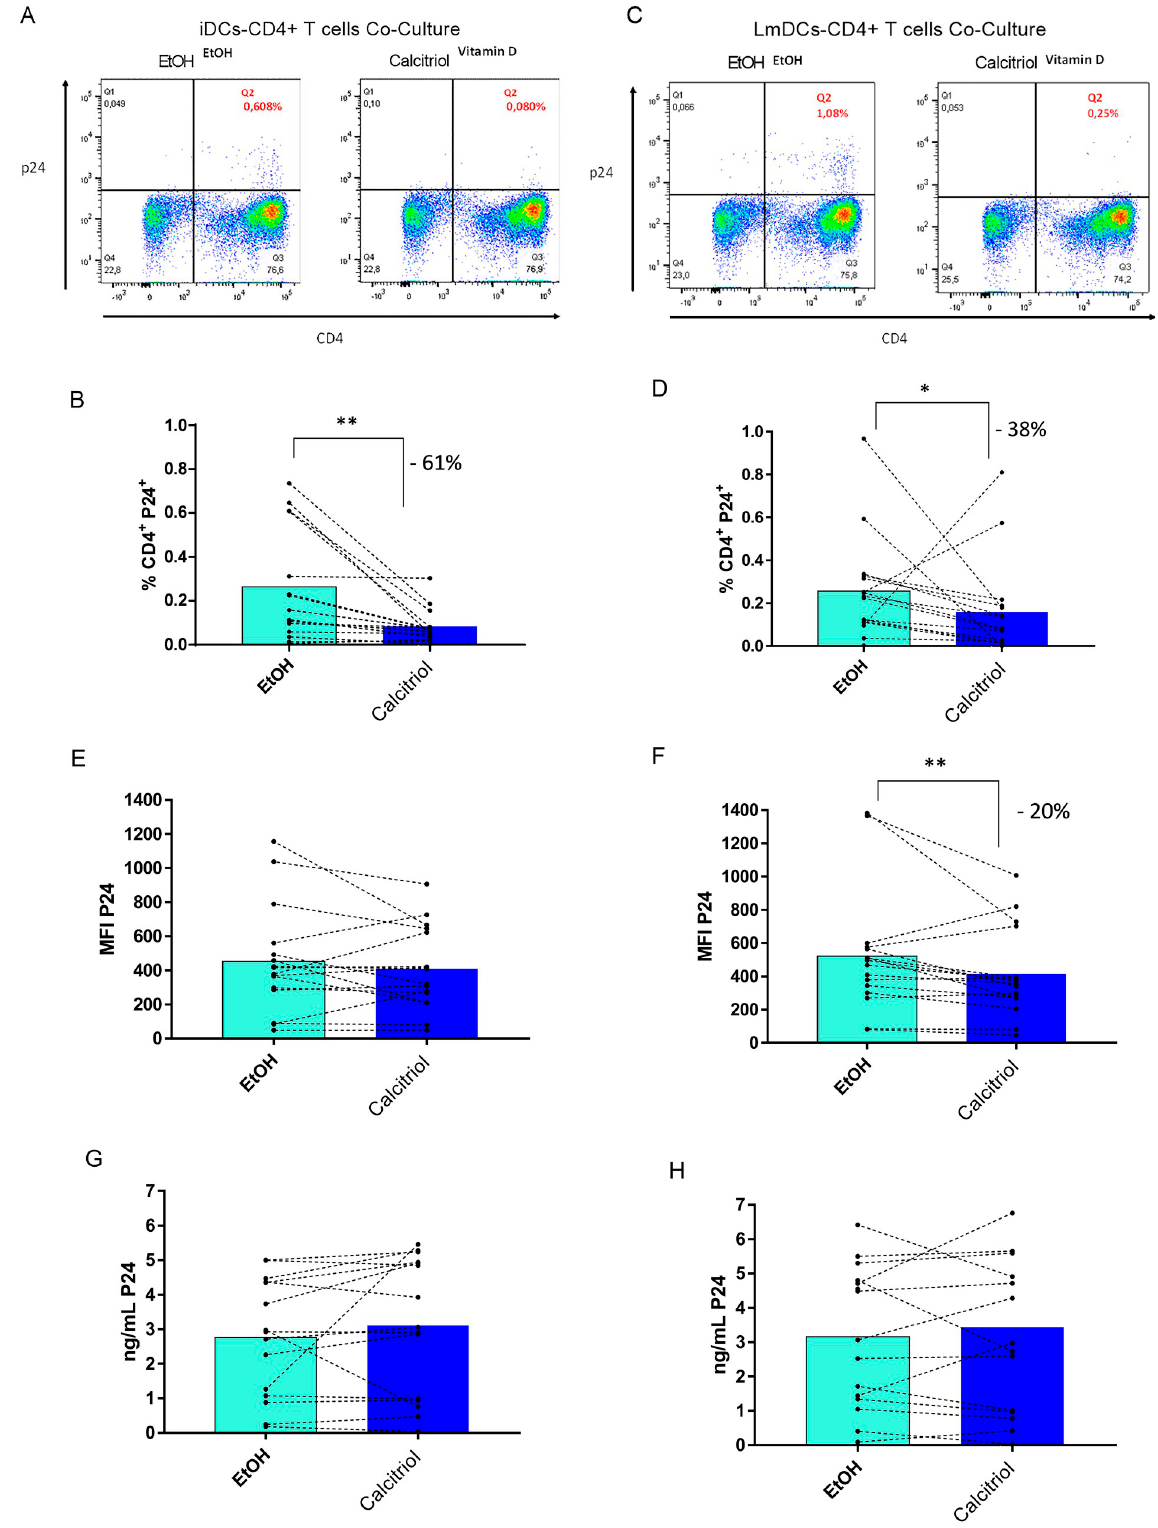
Fig 1. Percentage of infected CD4+ T cell is reduced when co-cultured with HIV-1 pulsed calcitriol-treated DCs. iDCs (left panel) and LmDCs (right panel) were pulsed with X4 tropic virions (H9-HTLV-IIIB) and co-cultured with CD4+ T cells. After 72 h, the viral protein p4